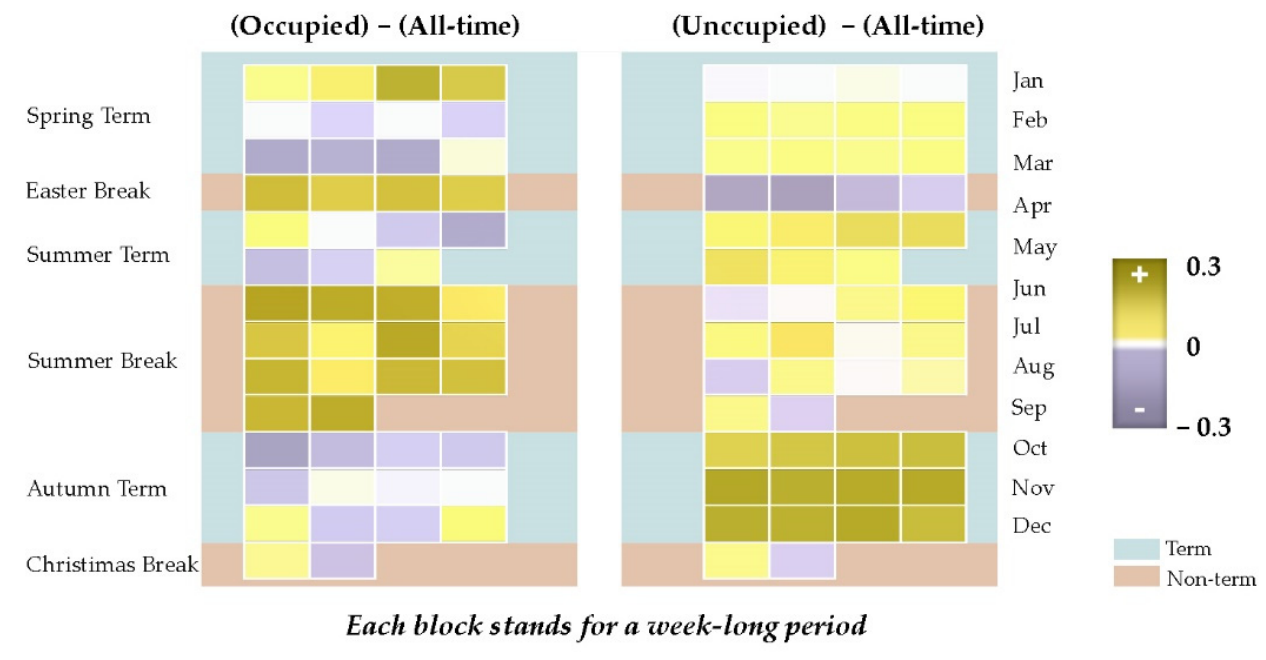
Figure 7. Difference in carbon emission scores between the segmented and all-time periods.